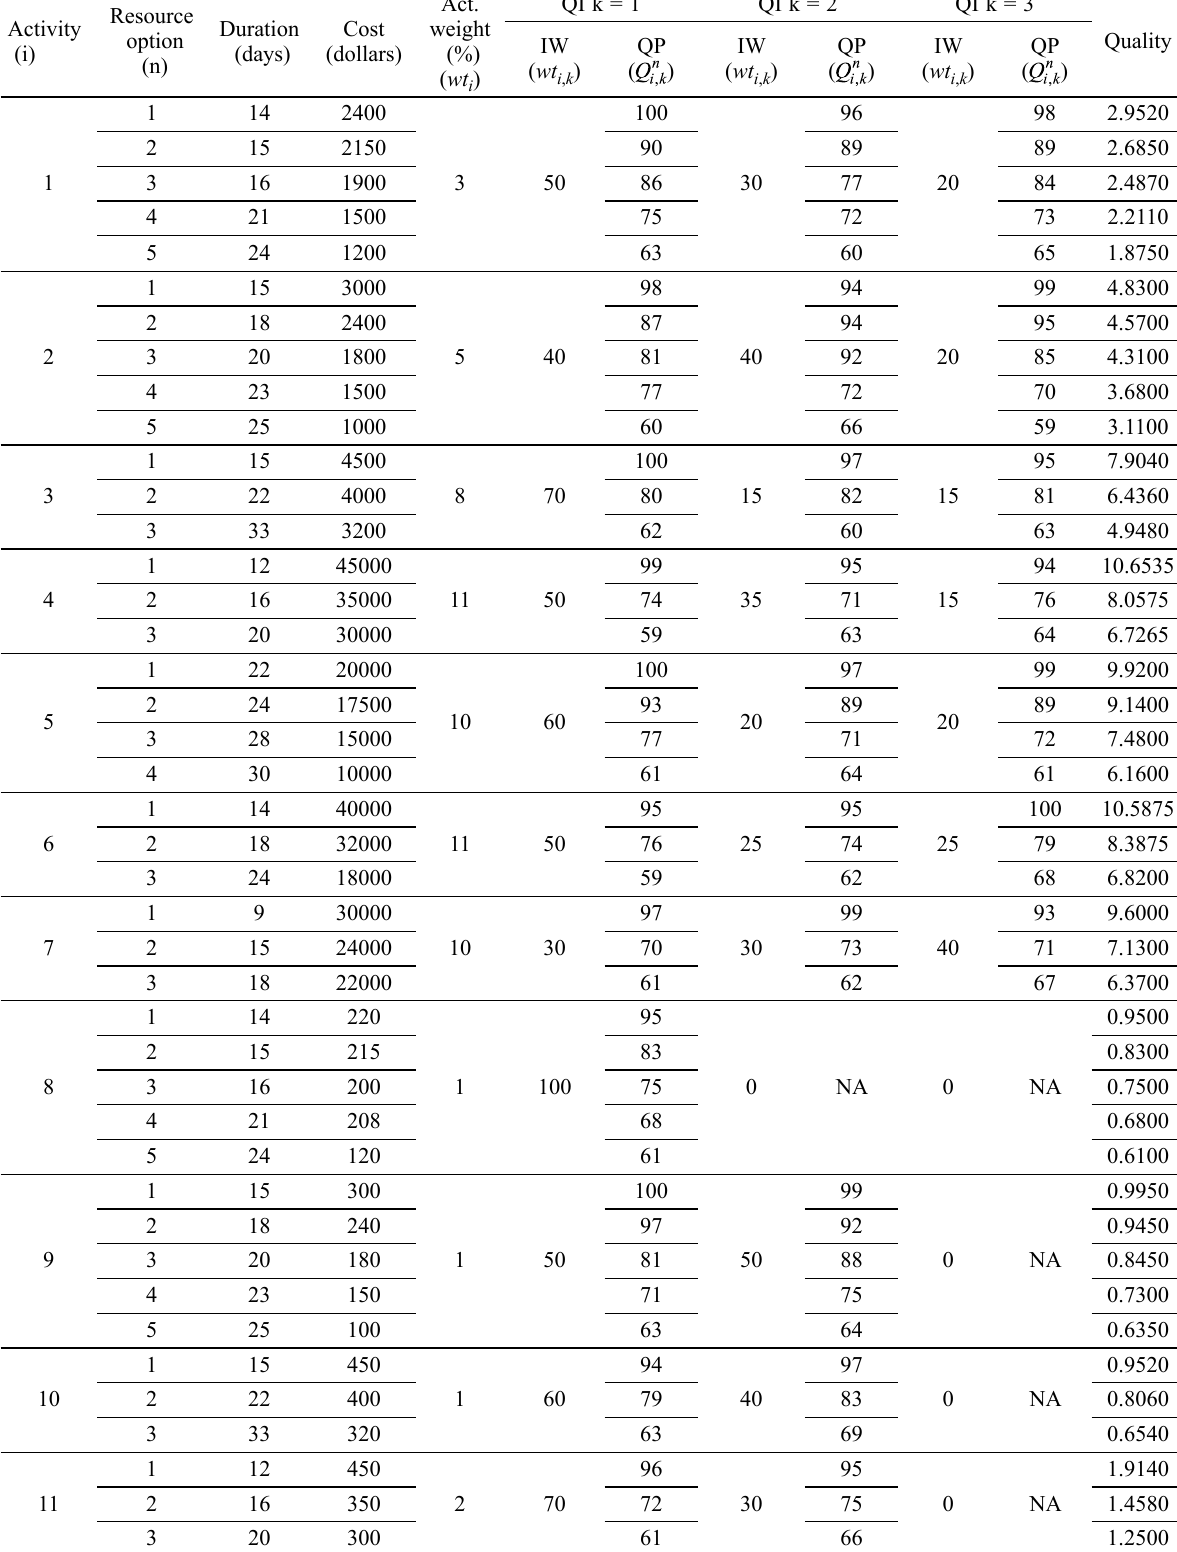
Table 1. Options of resource utilization Activity